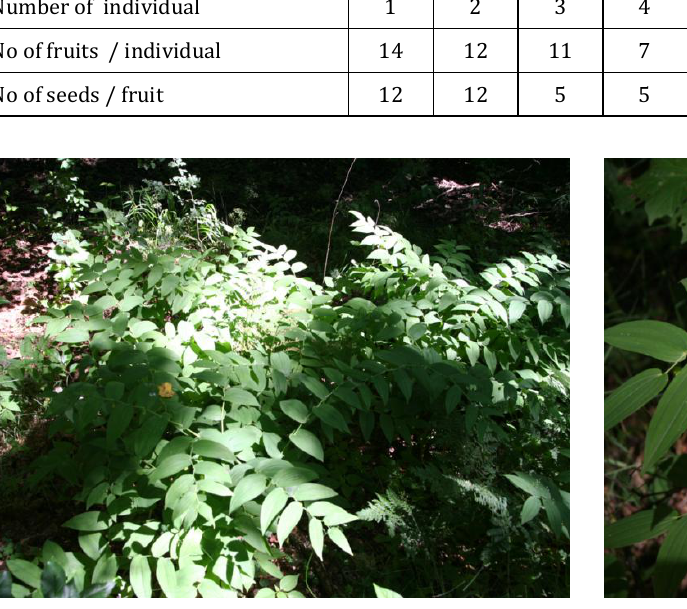
Fig. 3. View of an S. amplexifolius individual from the population near Koszęcin, Silesian voivodeship